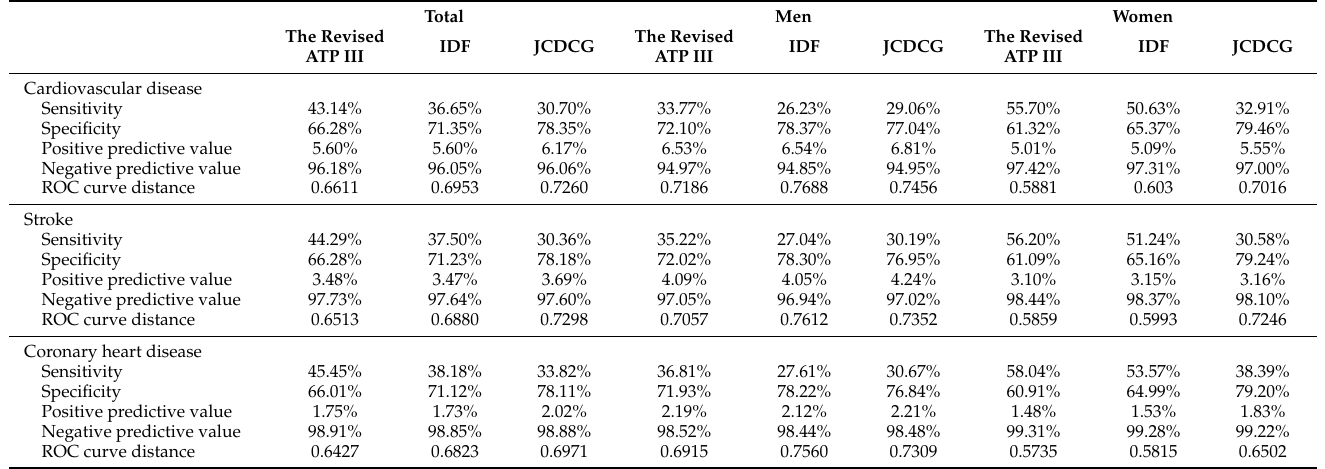
Table 4. The ROC curve analysis for the revised ATP, IDF, and JCDCG definitions as diagnostic tests for CVD, stroke, and